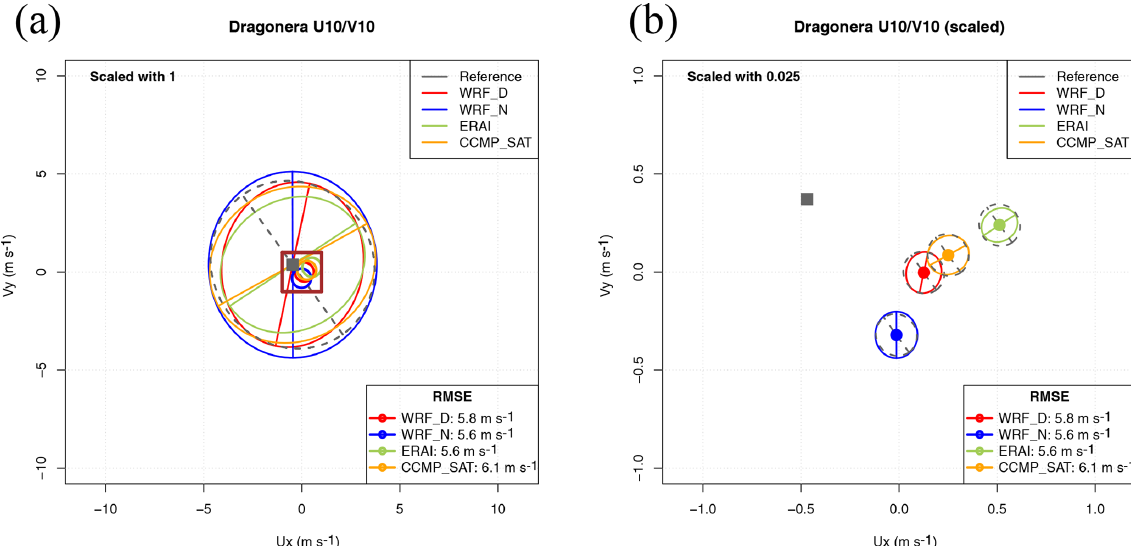
Figure 5. Sailor diagram with default parameters (a) and ellipses with a scale factor of 0.025 to improve visibility of the directional error (b) for the wind observed and simulated in Dragonera (buoy in the